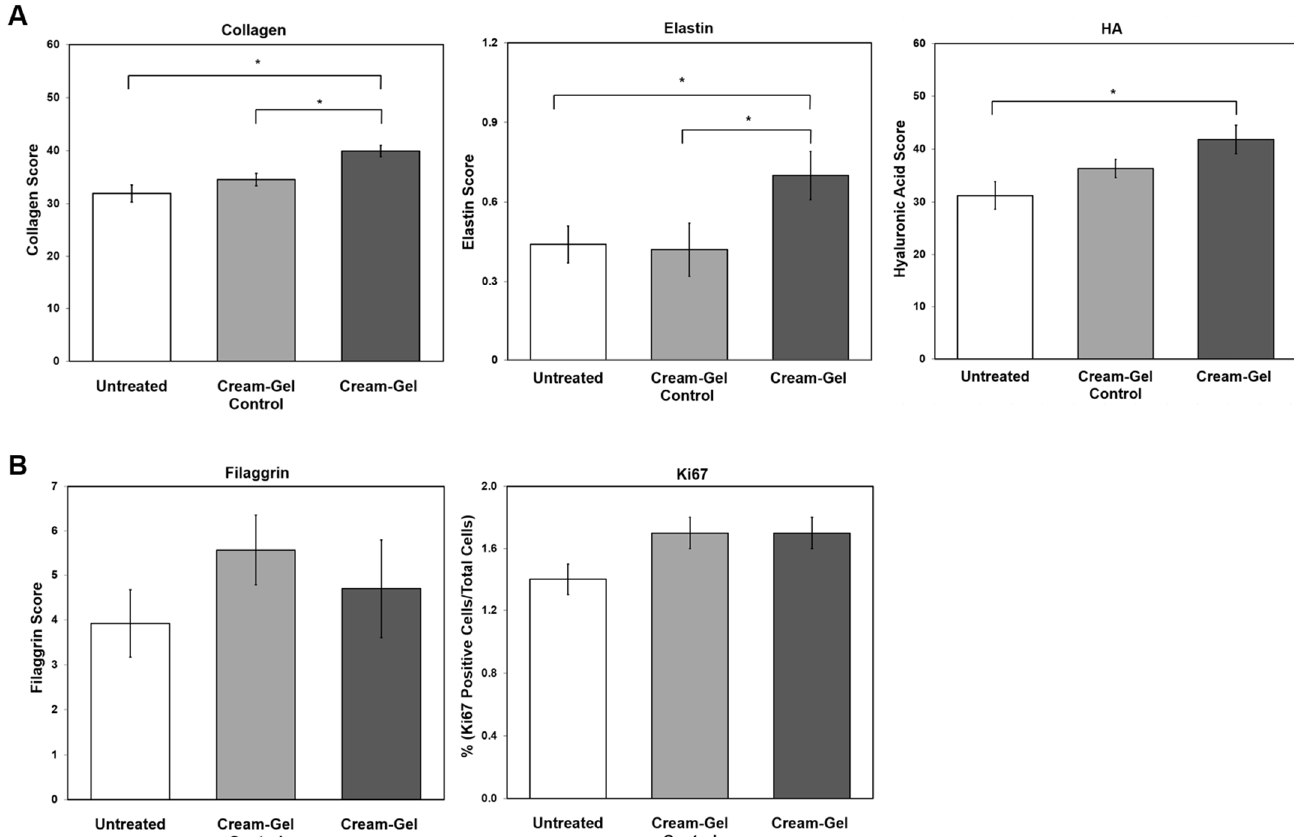
Figure 4. Quantitation score graphs of ( A ) ECM constituents (collagen, elastin and HA) and ( B ) epidermal barrier and proliferation markers (filaggrin and Ki67). The data presented are mean ± SEM. Statistical comparisons with untreated samples were determined by one-way ANOVA followed by t -test (* p < 0.05).